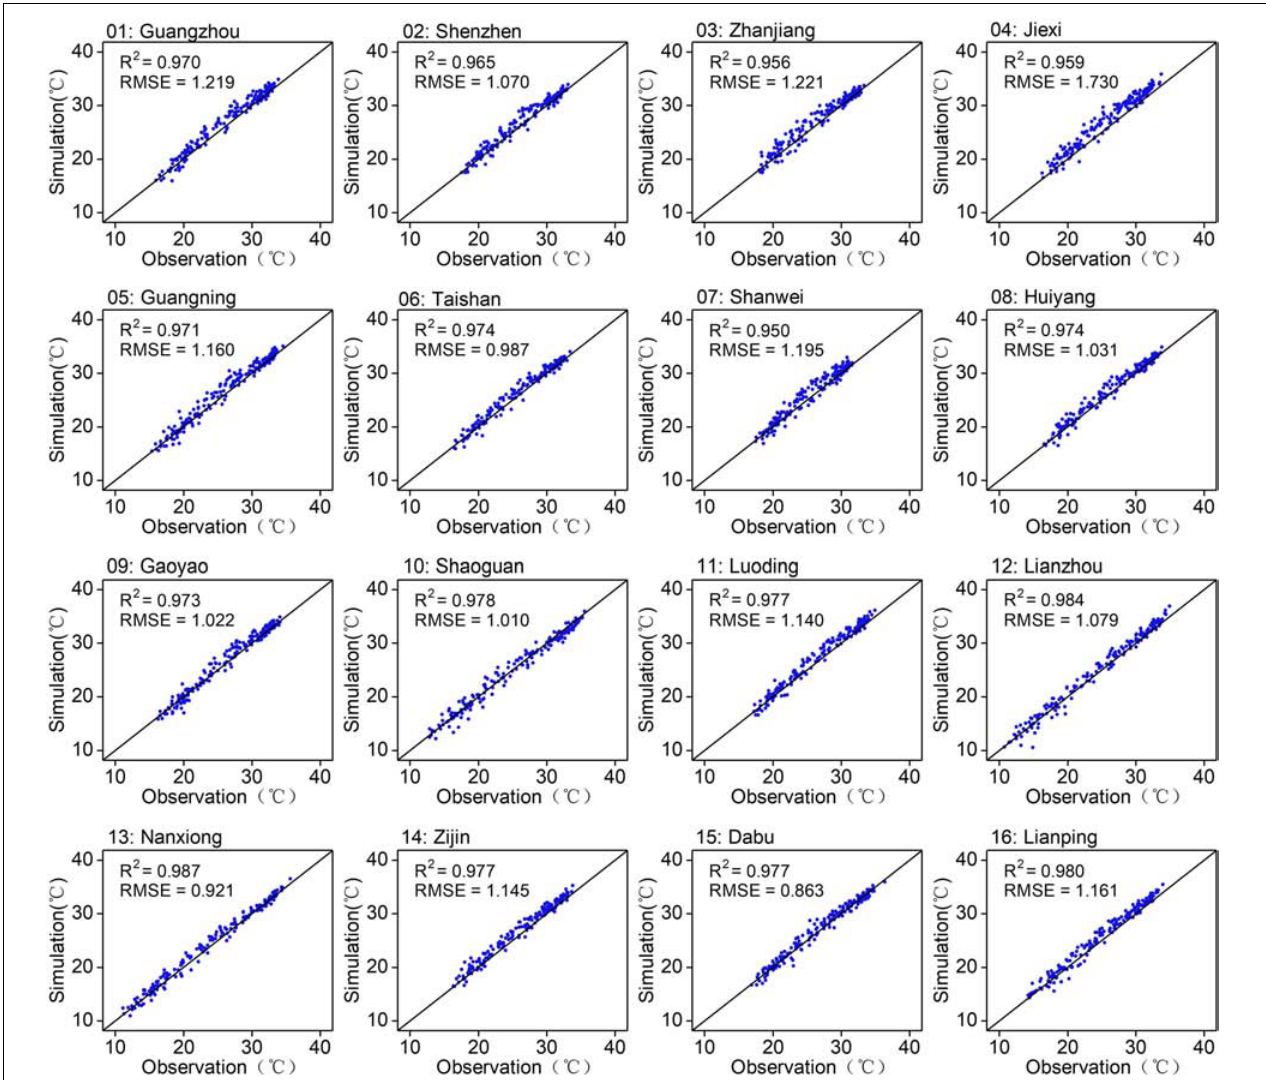
FIGURE 3 | Evaluation results for multiyear monthly average of Tmax between observed and NCEP/NARR reanalysis at the 16 selected weather stations,